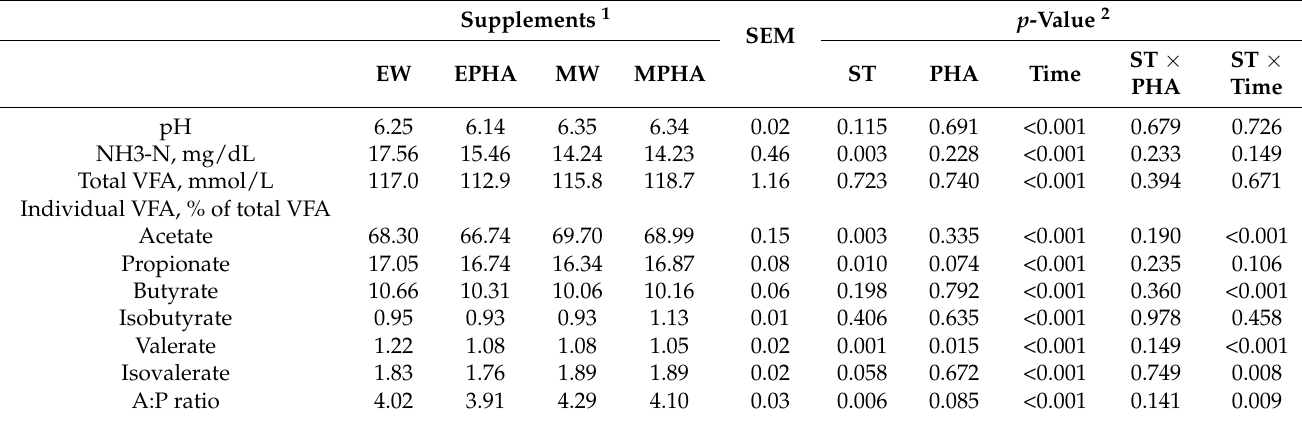
Table 4. Effect of phytogenic compounds in mineral or energy supplementation on ruminal fermenta- tion parameters in Nellore cattle grazing Urochloa brizantha cv. Marandu during the rainy season.